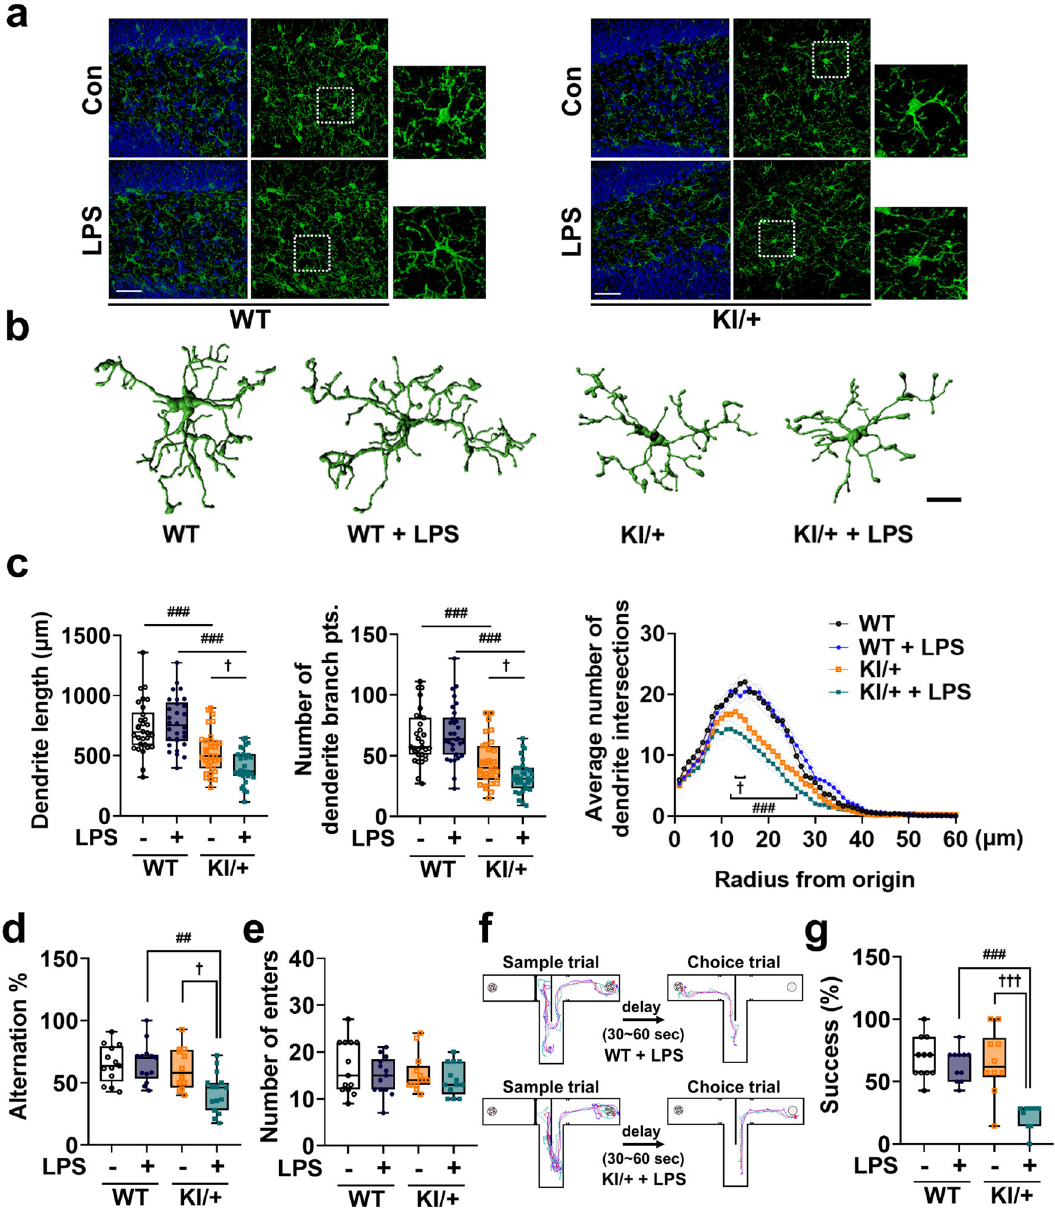
Fig. 3 Psen2 N141I mutation induces proin fl ammatory morphological changes in microglia and causes memory de fi cit in response to a mild LPS challenge. a Representative immuno fl uorescent images by IBA-1 staining in hippocampus of WT and KI/ + mice (8-week-old, male, n = 4 mice with similar results) 20 h after i.p. injection of LPS (0.35 μ g/kg body weight). Insets, 2.5-fold enlarged images. Scale bar, 25 μ m. b Representative 3D fi lament tracking images of IBA-1 signals made by IMARIS software. Scale bar, 10 μ m. c Dendrite length, number of branching branch points, and Sholl radius analysis. Data were extracted from FilamentTracker in IMARIS analysis ( n = 30 cells per group from four mice) (WT vs KI/ + : ### p = 0.0002 and ### p = 0.0003; KI/ + vs LPS-injected KI/ + : † p = 0.0448 and † p = 0.039; LPS-injected WT vs LPS-injected KI/ + : ### p < 0.0001; one-way ANOVA; radius 13 – 15 μ m, KI/ + vs LPS-injected KI/ + : † p = 0.0113, 0.0362, and 0.0398; radius 11 – 29 μ m, LPS-injected WT vs LPS-injected KI/ + : ### p < 0.0001; two-way ANOVA). d , e Y-maze test with WT and KI/ + mice (8-week-old, male, n = 13 mice per group) 20 h after LPS (0.35 μ g/kg body weight) i.p. injection for assessment of spatial working memory (KI/ + vs LPS-injected KI/ + : † p = 0.0391; LPS-injected WT vs LPS-injected KI/ + : ## p = 0.0029; one-way ANOVA). f , g T-maze test with WT and KI/ + mice (8-week-old, male, n = 11 mice per group) 20 h after LPS (0.35 μ g/kg body weight) i.p. injection for assessment of spatial learning and memory (KI/ + vs LPS-injected KI/ + : ††† p < 0.0001; LPS-injected WT vs LPS-injected KI/ + : ### p < 0.0001; one-way ANOVA). Tracking images indicate mouse head (blue line), center (red line), and tail (purple). The bounds of the box represent 25th to 75th percentiles ranges. The center lines with the box represent the mean value and whiskers represent the minimum to the maximum range ( c – g ). Data are mean ± SEM. † p < 0.05, and ††† p < 0.001 vs untreated KI/ + control. ## p < 0.01, and ### p < 0.001 for indicated comparisons. Source data are provided as a Source Data fi